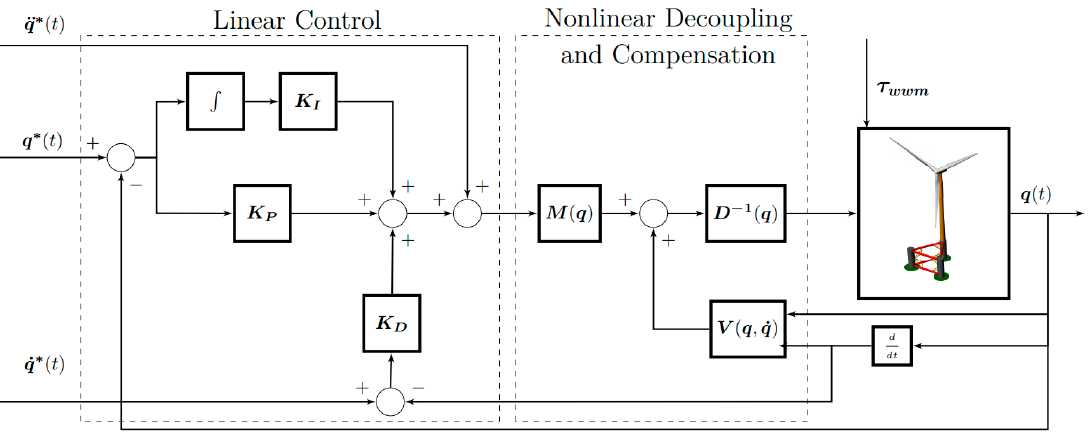
Figure 8. Nonlinear control scheme for the two degrees of freedom (DoFs)